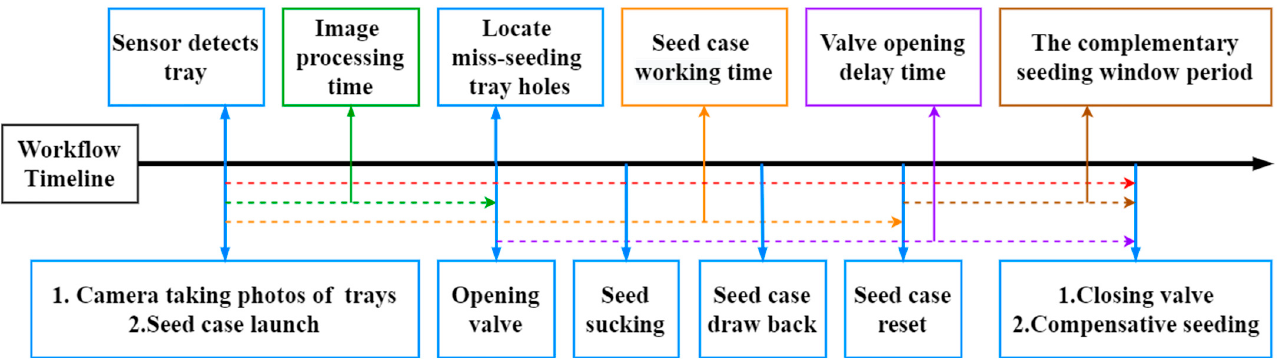
Figure 15. Complementary seeding process.